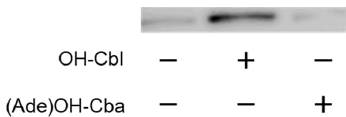
Figure 2. Western blotting of MS protein in the homogenate of COS-7 cells treated with or without (Ade)OH-Cba in the presence or absence of OH-Cbl. Cells were cultured in the medium containing OH-Cbl at 0 or 1 µM with or without 1 µM (Ade)OH-Cba for 2 days. The cell homogenate was centrifuged at 20,000× g for 20 min at 4 °C, and the supernatant was used as a source of the crude enzyme for Western blotting. MS protein on polyvinylidene difluoride (PVDF) membranes was visualized with goat polyclonal anti-MTR antibody. Data show typical immunoreactive patterns of the MS protein from three independent Western blot analyses of treated cells.